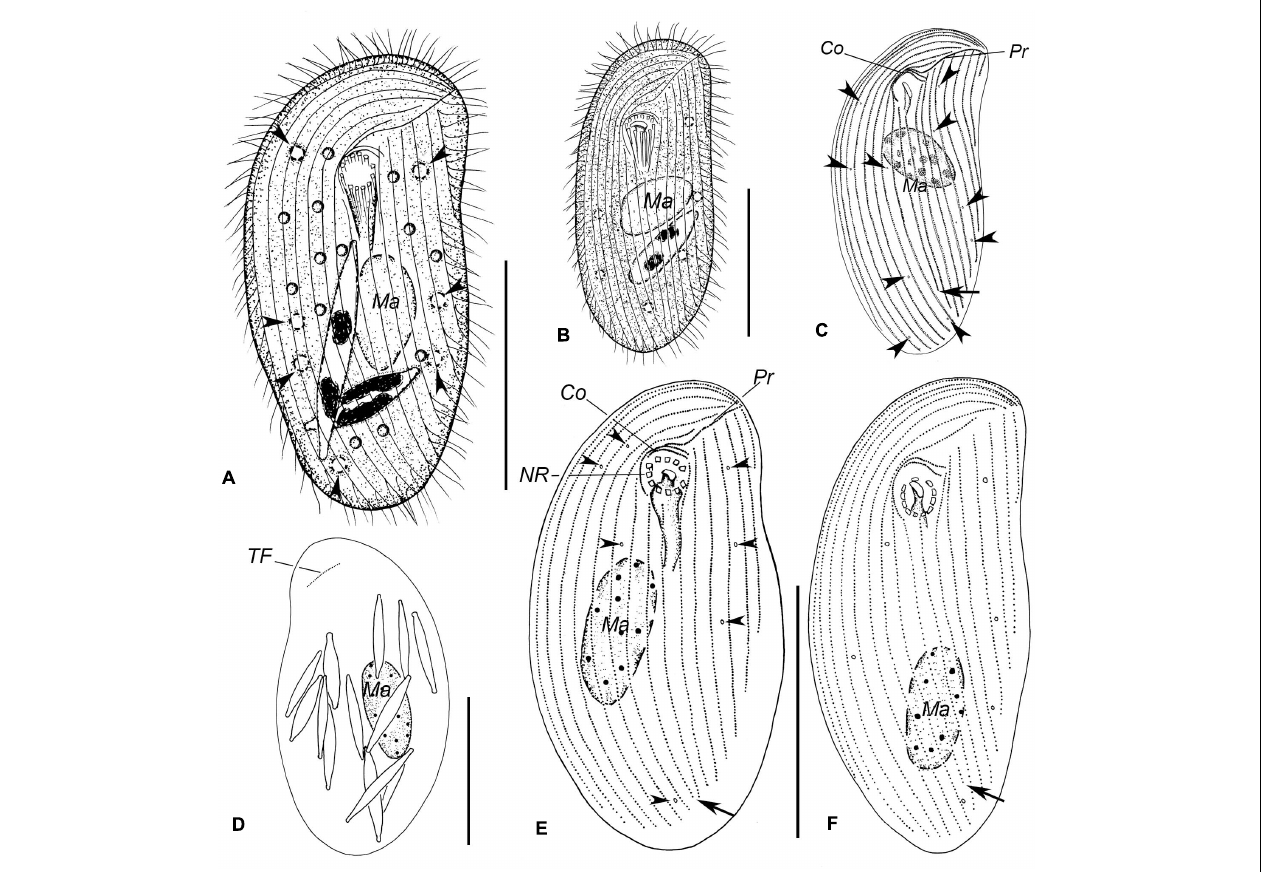
FIGURE 3 | Illustrations of Trithigmostoma cucullulus , Qingdao (A,B,D–F) and Zhanjiang populations (C) . (A,B) Ventral view of individuals in different body shapes. Arrowheads denote contractile vacuoles. (C,E,F) Ventral ciliature pattern. Arrows point to the end of the right postoral kinety, and arrowheads show the contractile vacuole pores. (D) Dorsal side, showing the terminal fragment as well as the food diatoms. Co, circumoral kineties; Ma, macronucleus; NR, nematodesmal rods; Pr, preoral kinety; and TF, terminal fragment. Scale bars: 40 µ m.